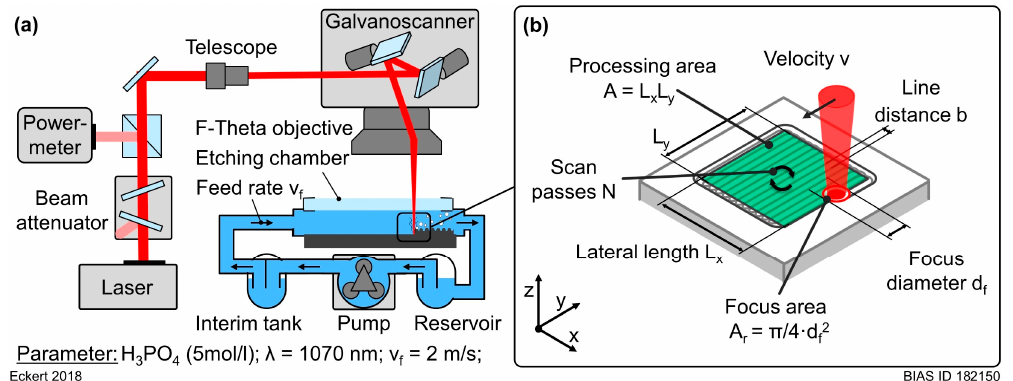
Figure 1. ( a ) Schematic illustration of the experimental setup for LCP and ( b ) machining parameters.